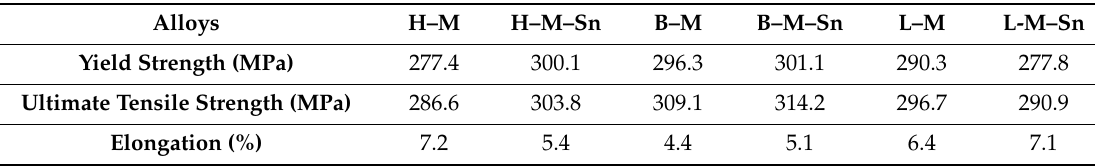
Table 2. Tensile results of the six peak aged investigated alloys.